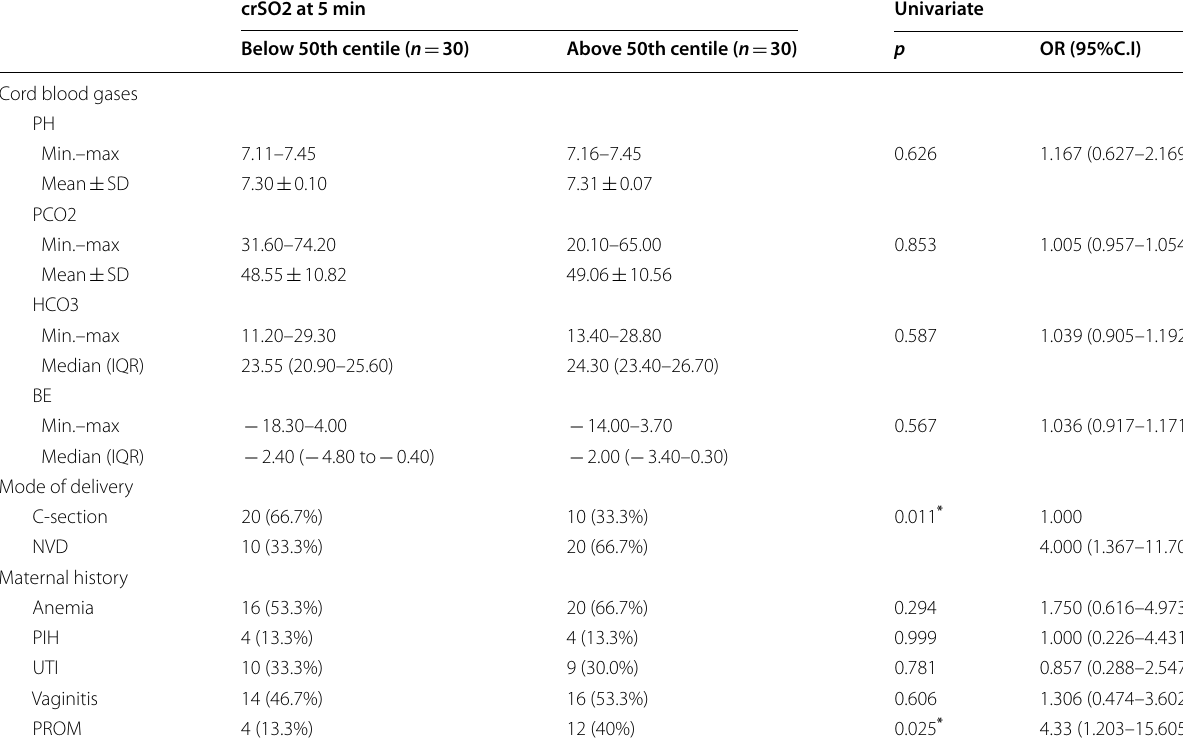
Table 4 Univariate logistic regression analysis for the parameters affecting cerebral regional oxygenation (crSO2) at 5